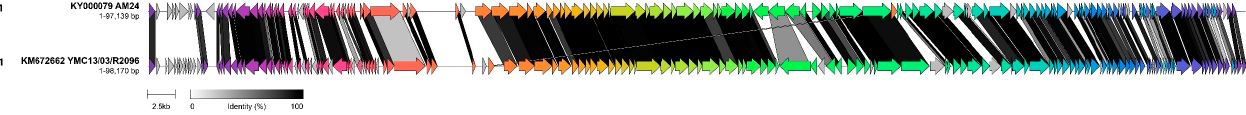
Figure 7. Comparative genome alignment of phages comprising sub-cluster D1. Phage genomes are presented alongside their designated sub-cluster, accession number, name and genome length. Coding sequences are represented by arrows, coloured to reflect homologous groups identified by Clinker, and are linked by grey bars shaded to represent the percentage amino acid identity, as indicated in the legend.